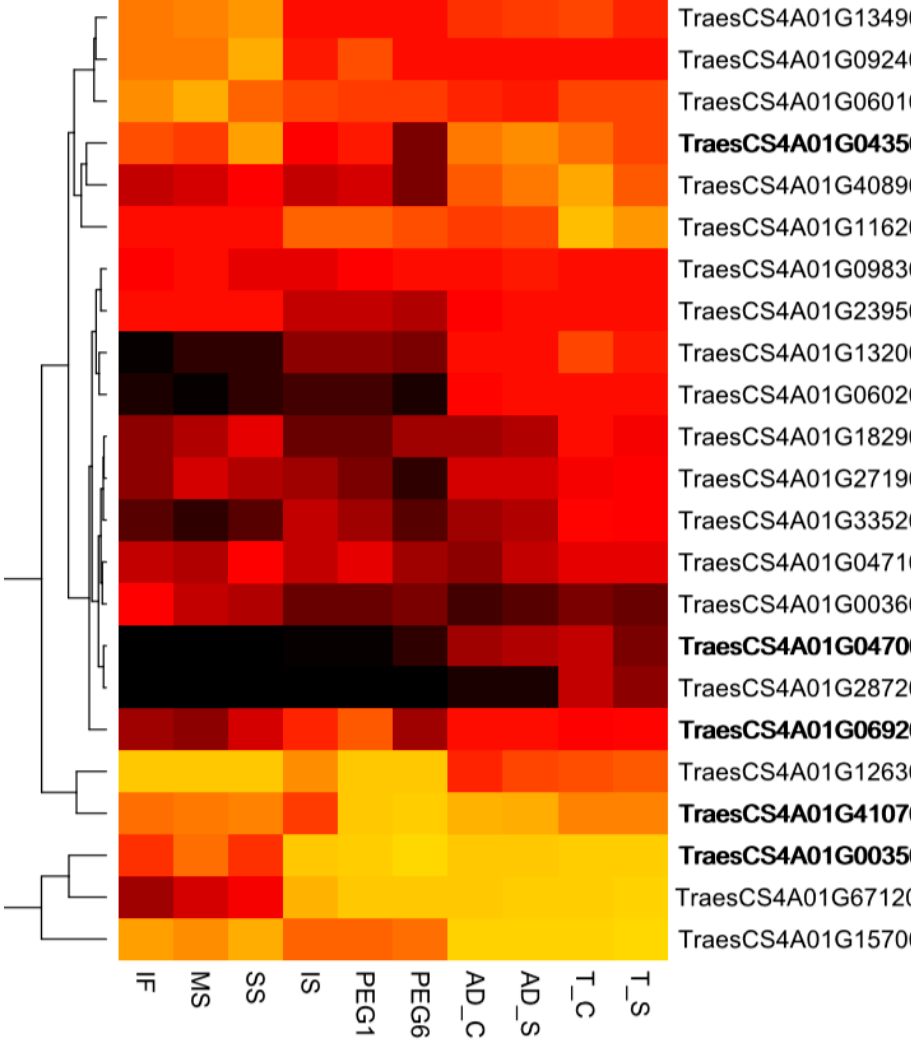
Figure 5. Gene expression analysis under different water stress conditions for candidate genes located within a window of +/–20 kb to the wheat chromosome 4A ISBP markers. Differentially expressed genes (DEGs) are shown in bold. IF: irrigated field conditions; MS: mild stress field condition; SS: severe stress field condition [27]; IS: seedling control; PEG1: seedling 1 h PEG stress; PEG6: seedling 6 h PEG stress [22]; AD_C: anther stage irrigated shelter phenotype; AD_S: anther stage drought stressed shelter phenotype; T_C: tetrad stage irrigated shelter phenotype; and T_S: tetrad stage drought shelter phenotype [26].